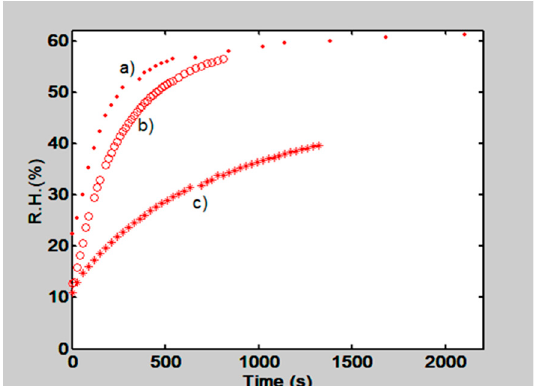
Figure 6. Behavior of Relative Humidity (RH) as a function of time when two gelatin films, a) and b), and a PAA/PVA film, c), were tested. Gelatin films presented thickness of 15 µm a) and 50 µm b). c) shows the behavior for a PVA/PAA, 50 µm film.